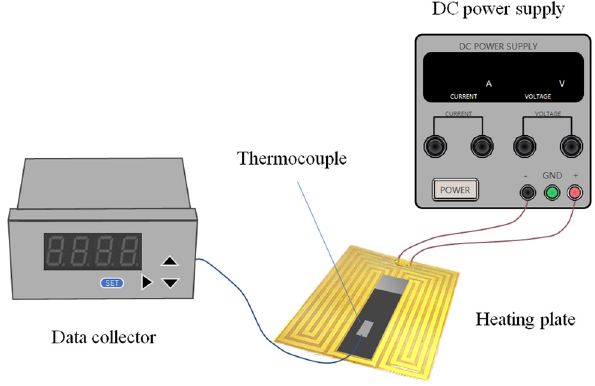
Figure 2: Schematic of heat transfer